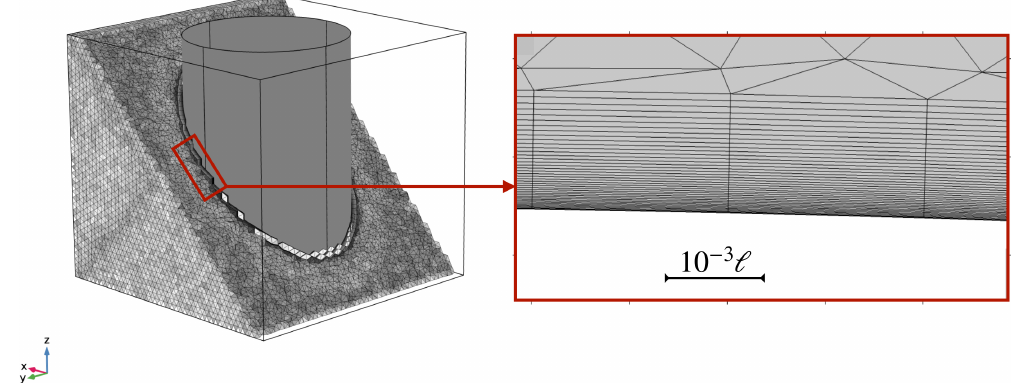
Figure 6. Left: Unstructured mesh used for the discretization of the effective domain Ω eff . In view of the small values of the coefficient 1/Pe p multiplying the Laplacian term at the right hand side of Equation (7), a larger number of finite elements is used for solving the particle transport equation with respect to those depicted in Figure 3 used for the Stokes problem. Right: Top view of the boundary layer mesh elements adjacent to the effective cylinder surface. Fourty boundary layer elements are distributed within the overall thickness of the boundary layer, of order 10 − 3 with respect to the length (cid:96) of the cell